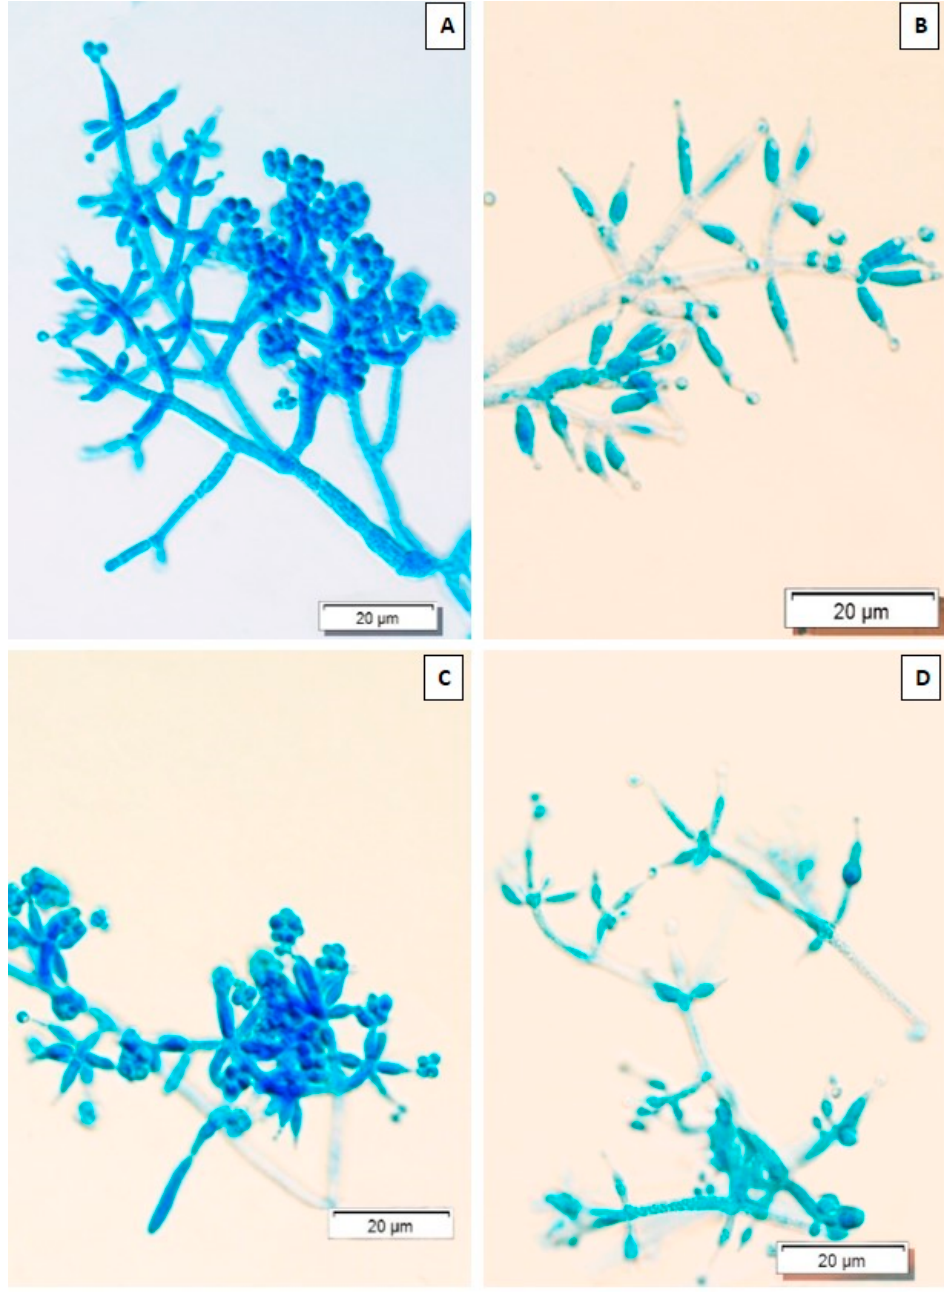
Figure A2. Trichoderma spp. conidia observed under the microscope. ( A ) CP 10-3; ( B ) CP53-2; ( C ) CP24-6; ( D ) CP38-2.